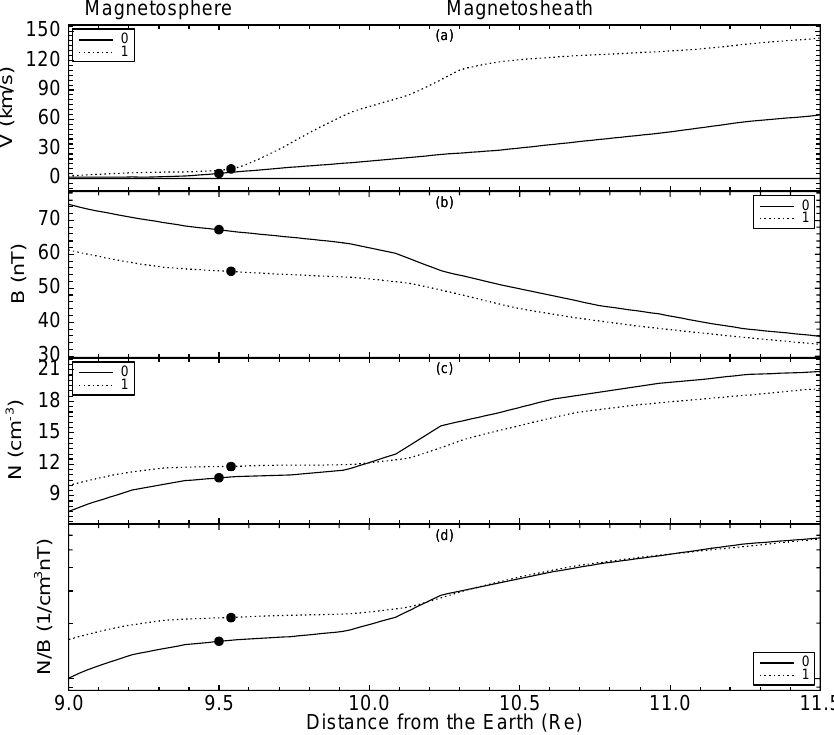
Fig. 10. Some parameters along lines 0 and 1 in Fig. 9. The black dots mark the locations of the magnetopause where the flow speed approaches